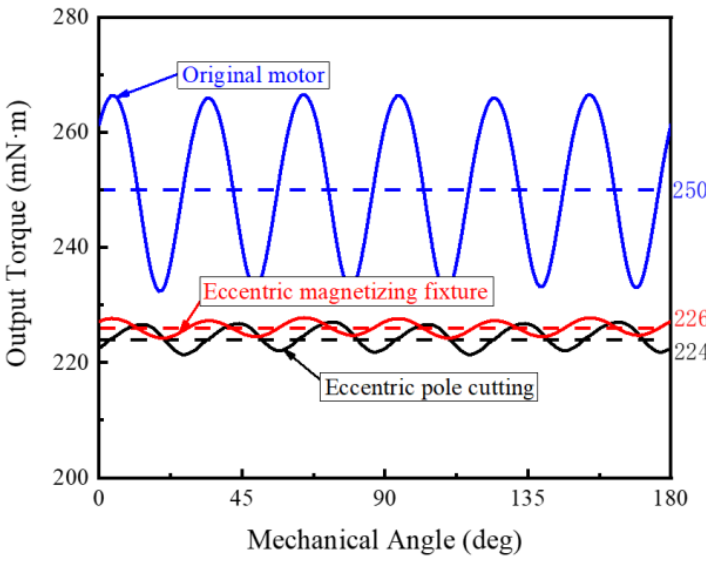
Figure 11. Comparison of rated output torque.